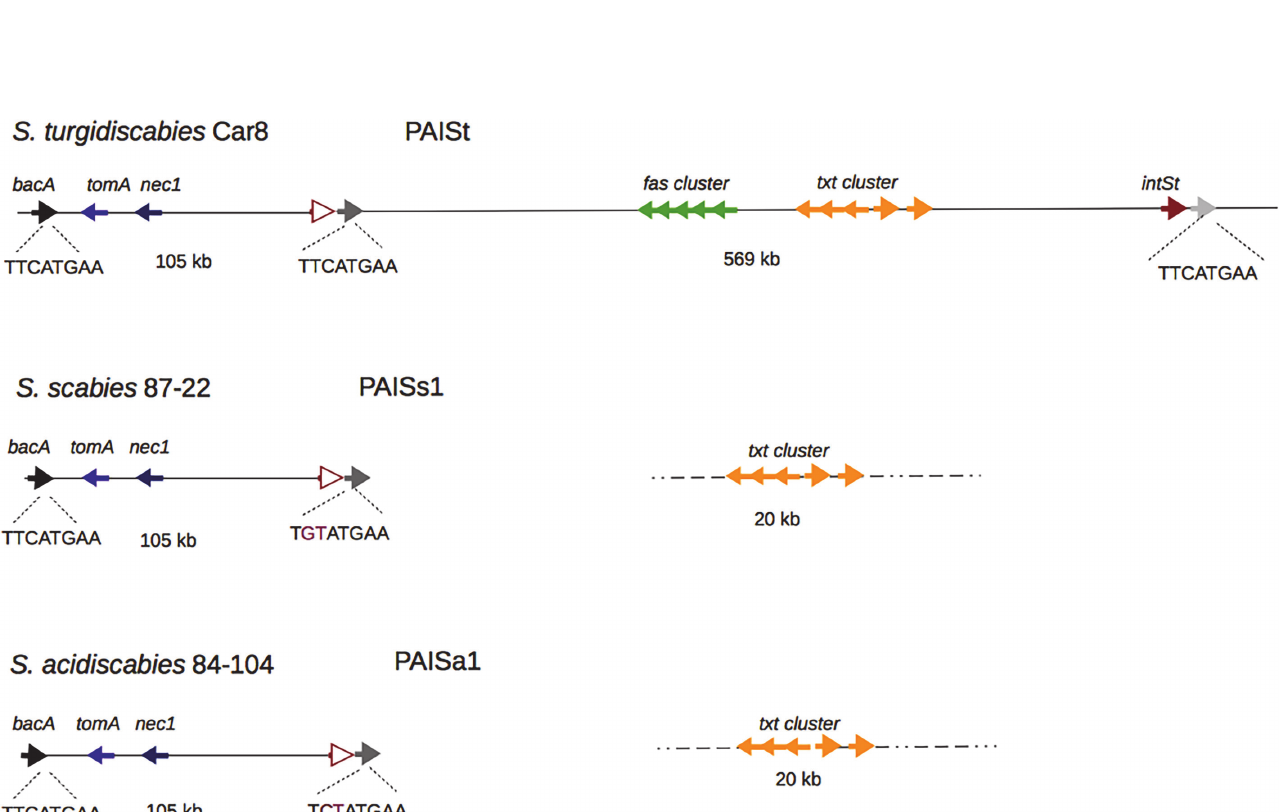
PLOS ONE | DOI:10.1371/journal.pone.0121152 April 1, 2015 2 /